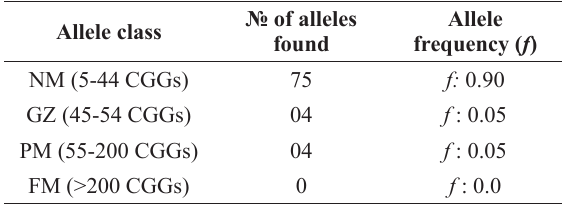
Frequency of the four classes of